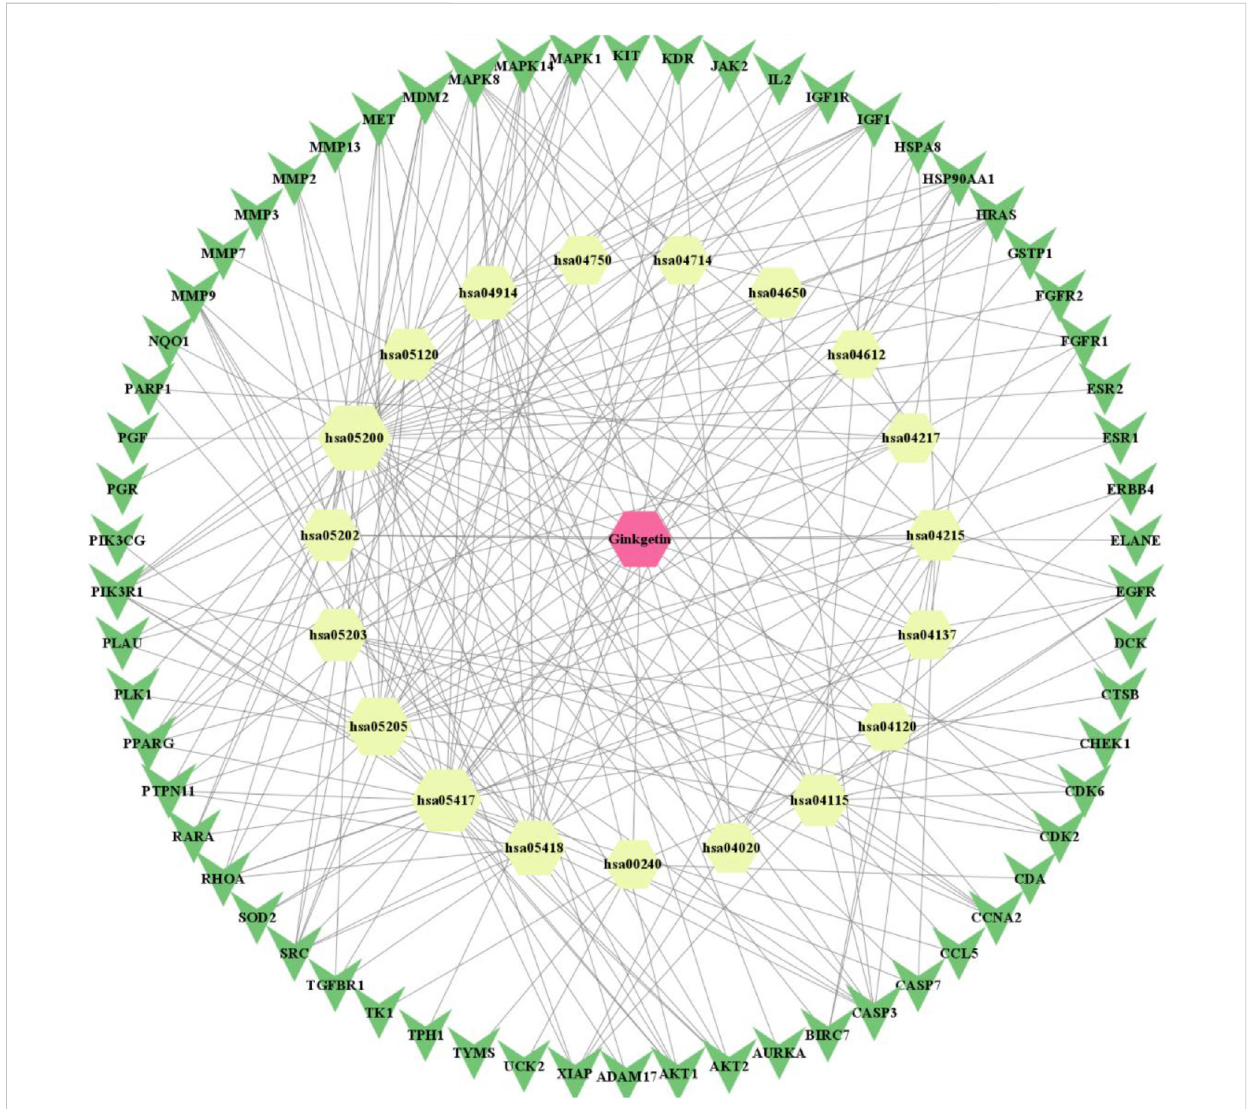
FIGURE 2 “ Drug-compound-target (including PPI)-pathway ” network diagram of Ginkgetin for lung cancer (red positive hexagon is Ginkgetin; yellow positive hexagon is the enriched pathway; green triangle is the intersecting gene).